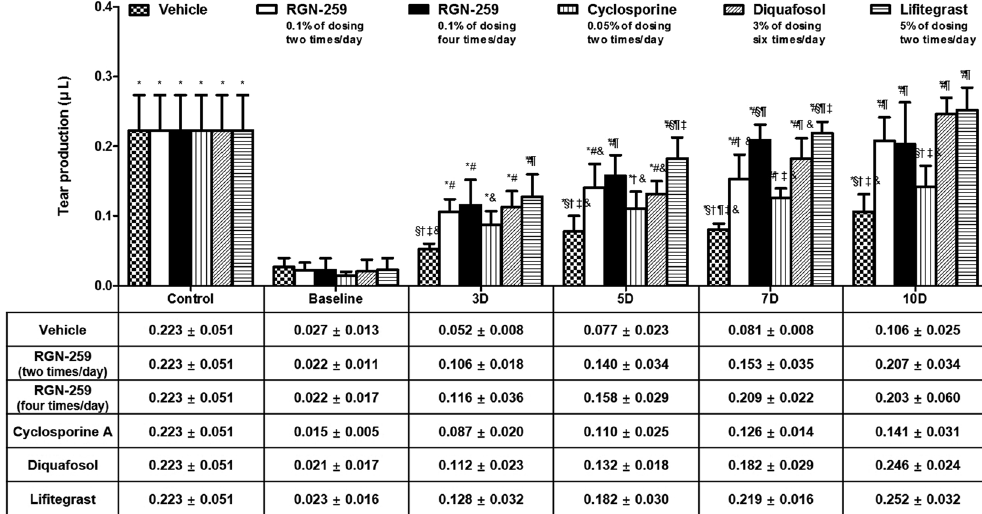
Figure 1. RGN-259 increased tear production comparable to that of DQS and LFA. Changes in tear volume in the experimental dry eye model are shown. * P < 0.05 vs. the corresponding value in the baseline desiccation stressed group. # P < 0.05 vs. the value in the vehicle-treated group. § P < 0.05 vs. the value in the RGN-259, 2 times per day group. † P < 0.05 vs. the value in the RGN-259, 4 times/day group. ¶ P < 0.05 vs. the value in the CsA group. ‡ P < 0.05 vs. the value in the DQS group. & P < 0.05 vs. the value in the LFA